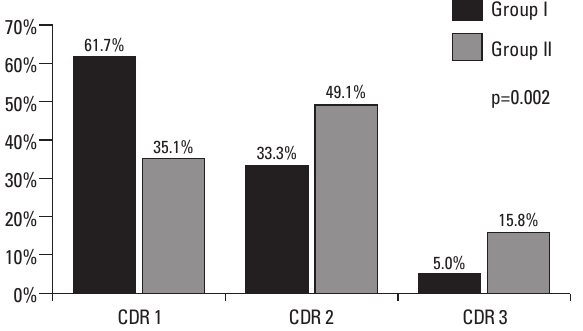
Figure 2. Disease stage (CDR) for Groups I and II